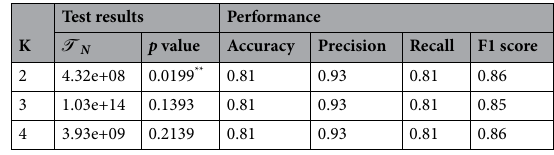
Table 3. Experiment result: determination of